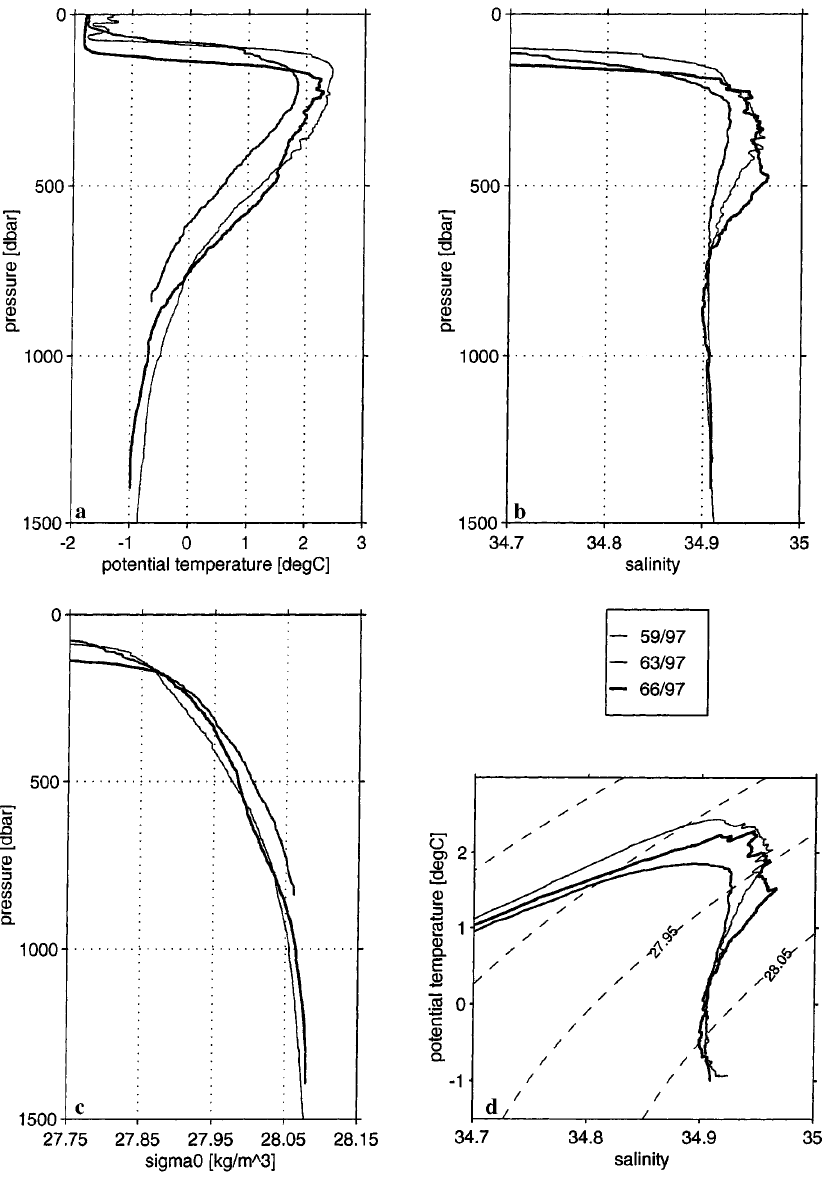
Fig. 7a–d. Profiles of potential tempera- ture, salinity and potential density, and Q -S diagram showing the di(cid:128)erence between the Yermak Plateau water column ( 63/97 ) and that of the two inflow branches ( 59/97 and